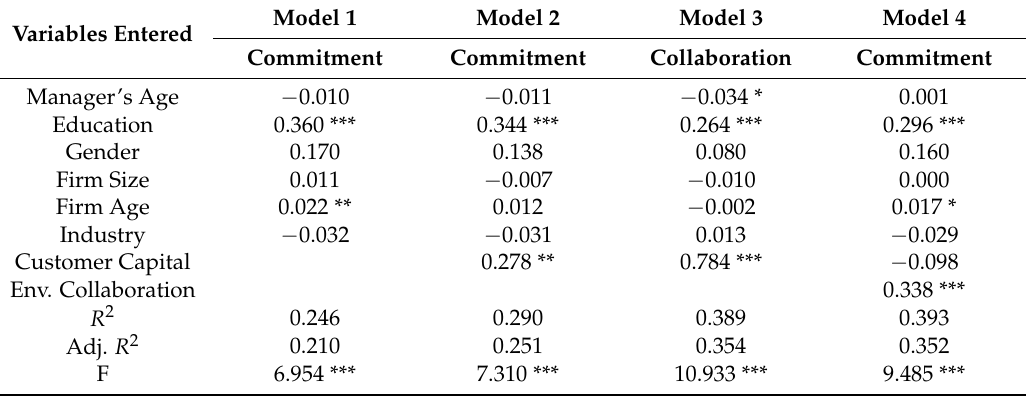
Table 2. Direct and indirect effect of customer capital on corporate environmental